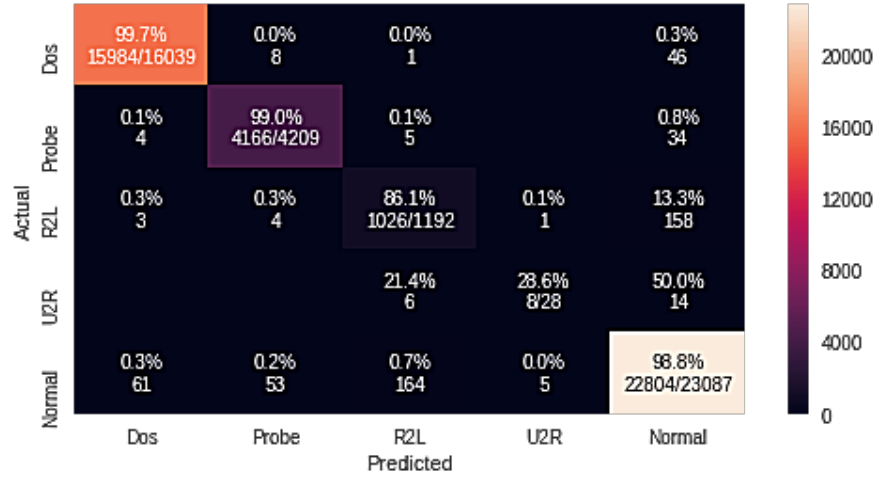
Figure 5. Random forest testing learning